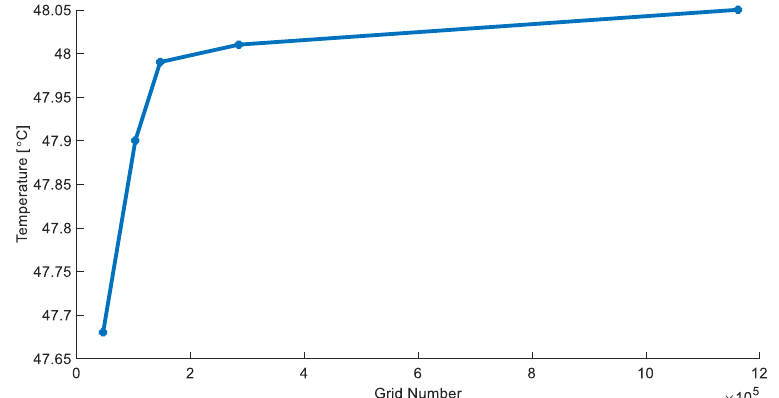
Figure 2. Mesh independence test showing variation in temperature with the grid number.